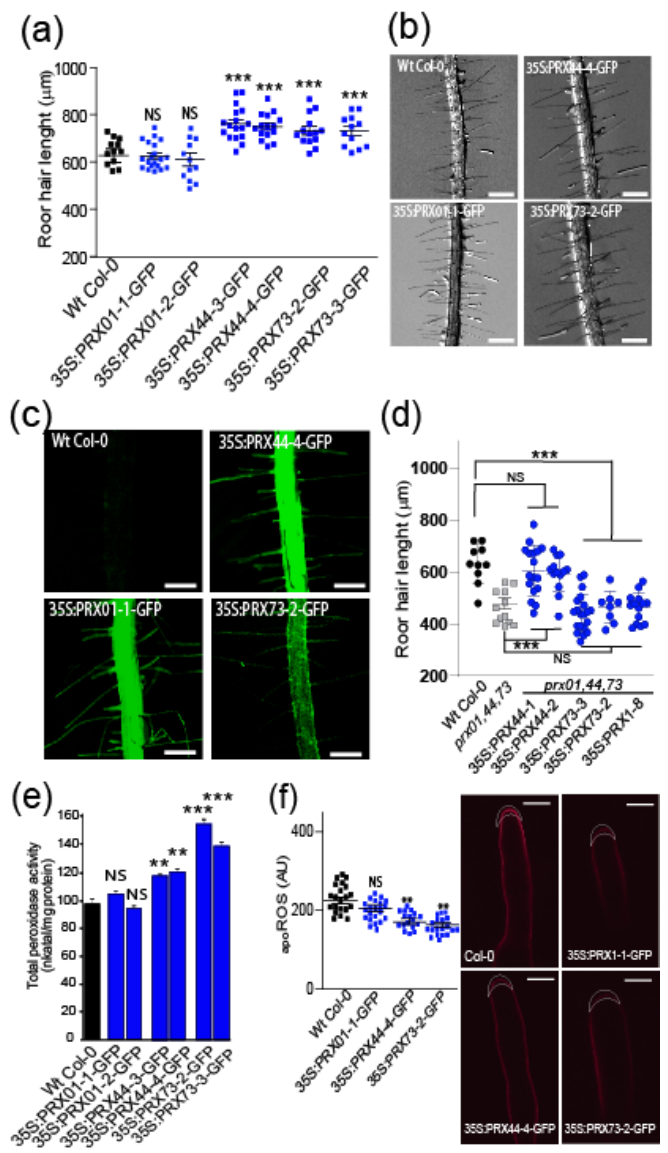
Figure 2. Partially redundant functions of PRX01, PRX44, and PRX73 in promoting root hair growth linked to their peroxidase activity. ( a ) Root hair length phenotype of Wt Col-0 and 35S:PRX lines (in Wt Col-0 background). Box-plot of root hair length. Horizontal lines show the means. p -values determined by one-way ANOVA, (***) p < 0.001, (NS) not significantly different. ( b ) Bright-field images exemplifying the root hair phenotype analyzed in ( a ). Scale bar = 0.5 mm. ( c ) Expression of GFP-tagged 35S:PRX01, 35S:PRX44, and 35S:PRX73 in root hair cells. ( d ) Root hair length phenotype of Wt Col-0, prx01,44,73 triple mutant, and 35S:PRX lines (in prx01,44,73 triple mutant background). Left, box-plot of root hair length. Horizontal lines show the means. p -value determined by one- way ANOVA, (***) p < 0.001. ( e ) Assays of total peroxidase activity in Wt and 35S:PRX lines (in Wt Col-0 background). Enzyme activity (expressed in nkatal/mg protein) was determined by a guaiacol oxidation-based assay. Values are the mean of three replicates ± SD. p -values determined by one-way ANOVA, (***) p < 0.001, (**) p < 0.01, (NS) not significantly different. ( f ) Apoplastic ROS levels measured with Amplex™ UltraRed (AUR) in Wt Col-0 and 35S:PRX lines (in Wt Col-0 background). ROS signal was quantified from the root hair cell tip. Left, box-plot of apo ROS values. Horizontal lines show the means. p -values determined by one-way ANOVA, (**) p < 0.01, (NS) not significantly different. Right, fluorescence images exemplifying apo ROS detection in root hair apoplast. Scale bar = 10 µ